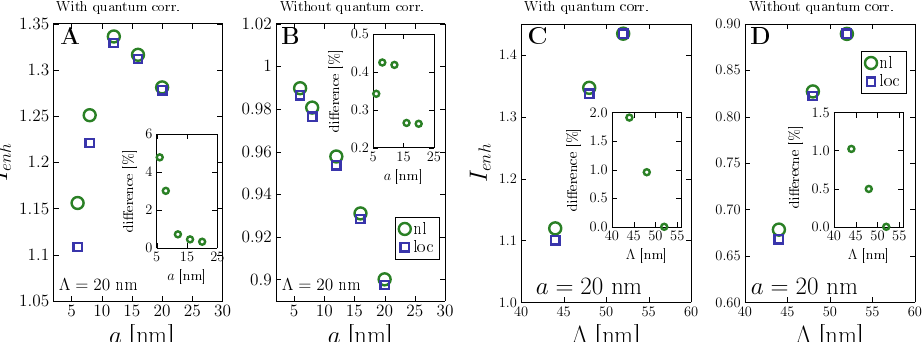
Figure 4. Impact of nonlocality on the photocurrent with and without particle–substrate coupling. The lattice period is Λ = 20 nm. The insets show the difference between classical and nonlocal theory results. ( A ) Strong coupling approach for various nanoparticle radii a and constant interparticle separation Λ = 20 nm. ( B ) As in ( A ) for the standard classical theory. ( C ) Strong coupling approach for the radii a = 20 nm and various interparticle separations Λ . ( D ) As in ( C ) for the standard classical